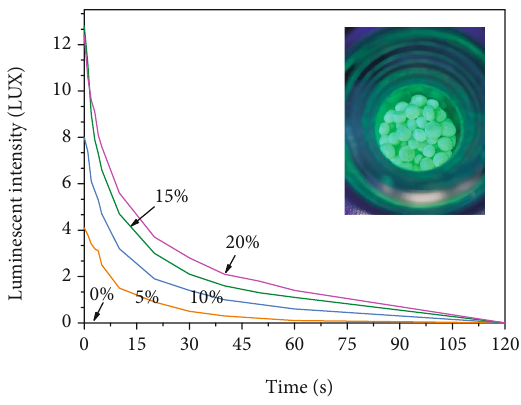
Figure 7: Luminescence decay curves of phosphor-in-glass ceramic aggregates with varying phosphor